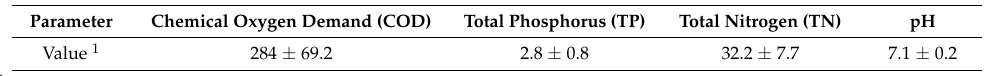
Table 2. The chemical characteristics of decentralized domestic wastewater (unit: mg/L, except for